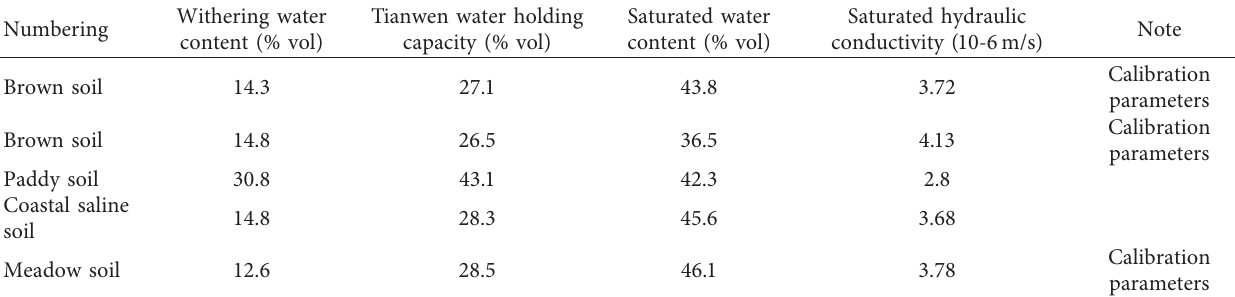
Table 2: Calculation of soil parameters.